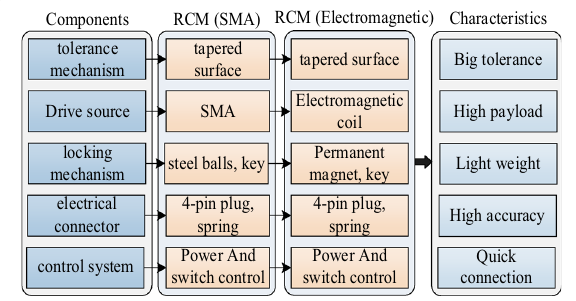
Figure 1 Components, methods, and characters of two